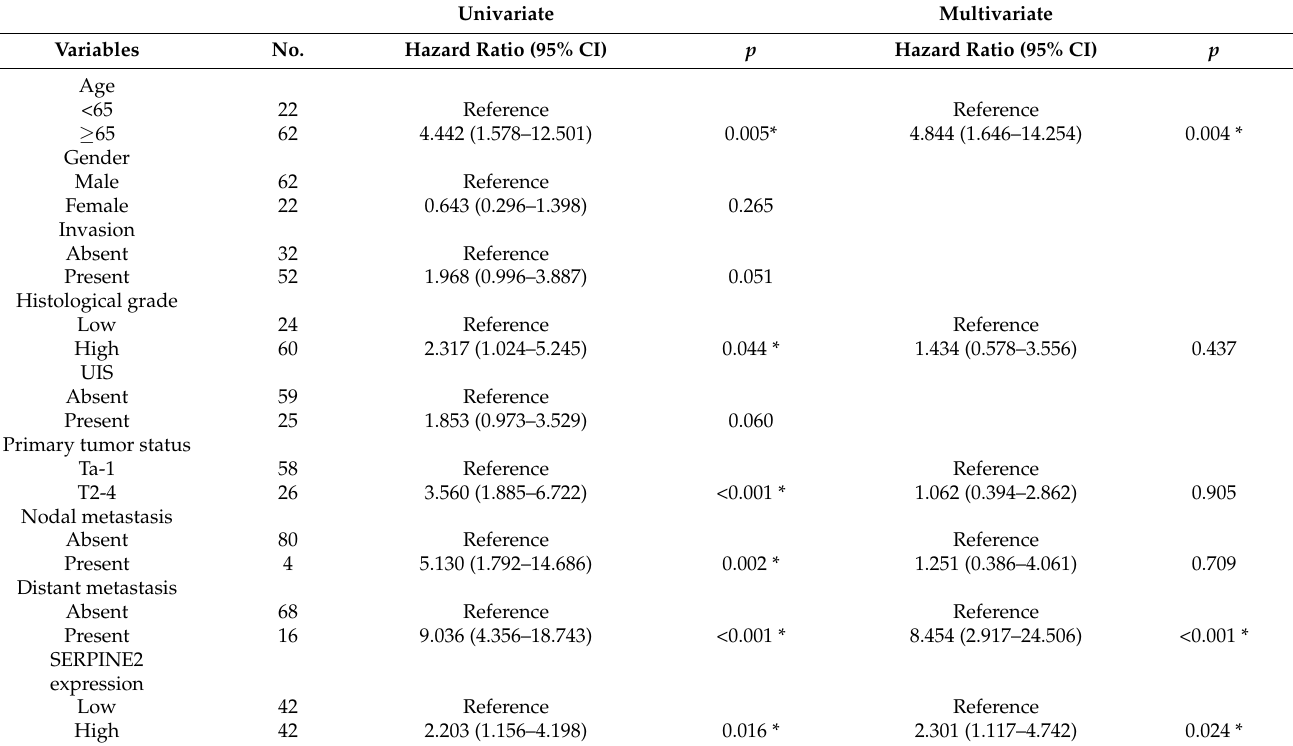
Table 3. Univariate and multivariate analysis of SERPINE2 in OS of 84 UBUC patients. Univariate